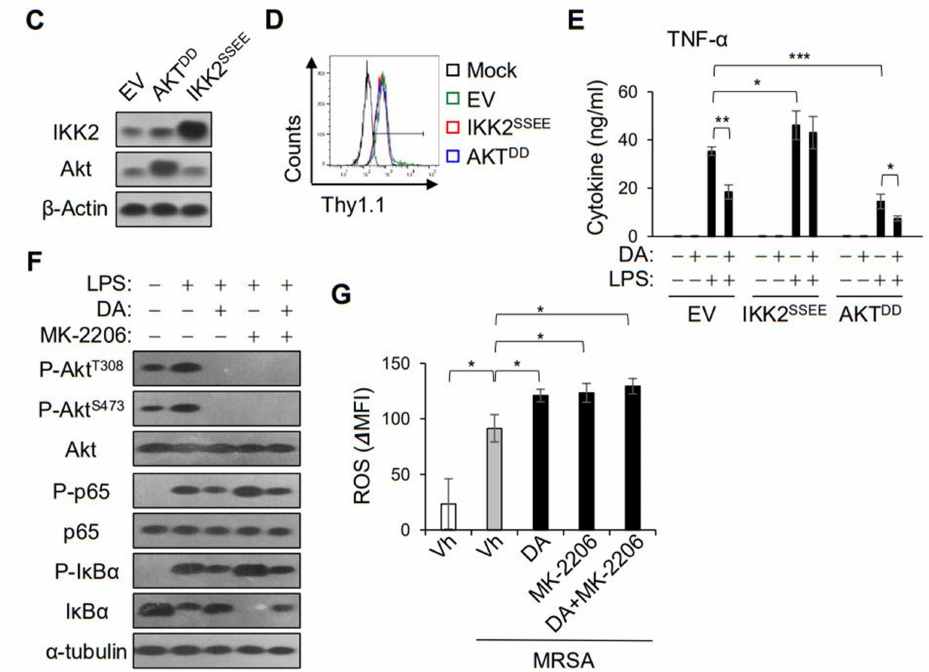
Figure 6. DA modulates NF- κ B and Akt signaling pathways. ( A , B ) BMDMs were pretreated with 20 µ M DA followed by LPS stimulation over a time-course and analyzed by Western blotting with the indicated antibodies. Representative immunoblots from three independent experiments are shown. Immunoblotting for α -tubulin and unphosphorylated proteins was used as a loading control. ( C – E ) RAW 264.7 cells were transfected with the indicated plasmids, and ectopic expression of IKK2 SSEE and Akt DD was confirmed by Western blotting ( C ) and flow cytometry ( D ). Cells were pretreated with DA, and secretion of TNF- α was determined 8 h after LPS activation ( E ); n = 3. ( F , G ) BMDMs were pretreated with 20 µ M DA, 1 µ M MK-2206, or both. One hour after LPS stimulation, the cells were analyzed by Western blotting with the indicated antibodies, and ROS production was determined by flow cytometry; * p < 0.05, ** p < 0.01, *** p <